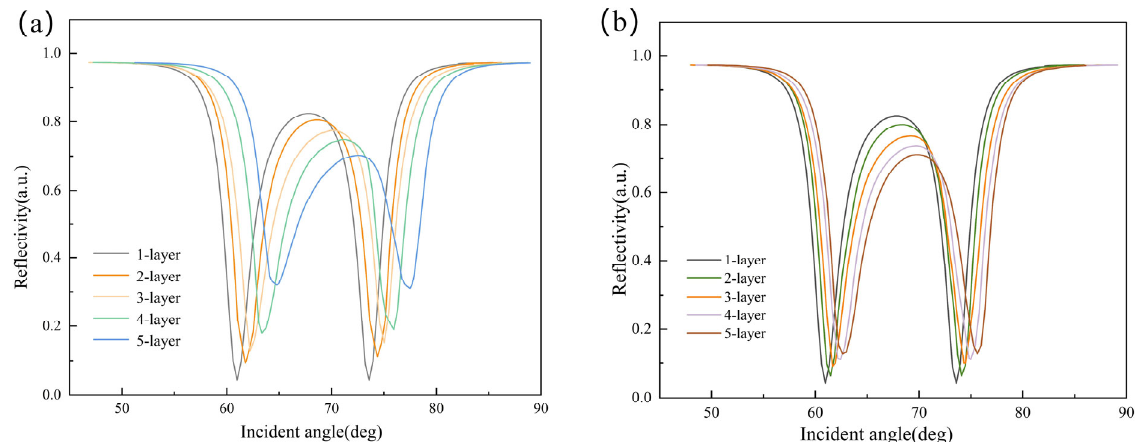
Figure 5. Functional relationship between the reflectivity and incident angle: ( a ) reflectivity curve when graphene was set as a single layer and the ws 2 layer was added; ( b ) reflectance function curve when the number of graphene layers was gradually increased (WS 2 was set to a single layer).